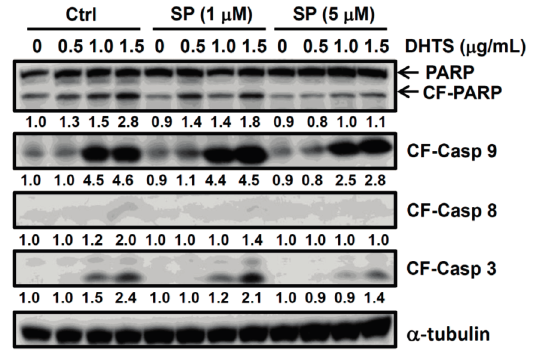
Figure 5. Effects of a c-Jun N-terminal kinase (JNK) inhibitor on 15,16-dihydrotanshinone I (DHTS)-induced cleavages of poly ADP ribose polymerase (PAPR) and caspases in human HL-60 promyelocytic leukemia cells. Cells were pretreated with the JNK inhibitor, SP600125, for 1 h, and treated with various concentrations of DHTS for 24 h. Total cellular proteins were collected to determine protein expressions by Western blotting. SP, SP600125; CF, cleaved form; CF-casp-3, cleaved form of caspase-3; CF-casp-8, cleaved form of caspase-8; CF-casp-9, cleaved form of caspase-9. Relative intensities of CF-PARP and CF-caspases were quantified using ImageJ, normalized versus internal controls α -tubulin, and shown below the band pictures. Three independent experiments were performed and representative results are